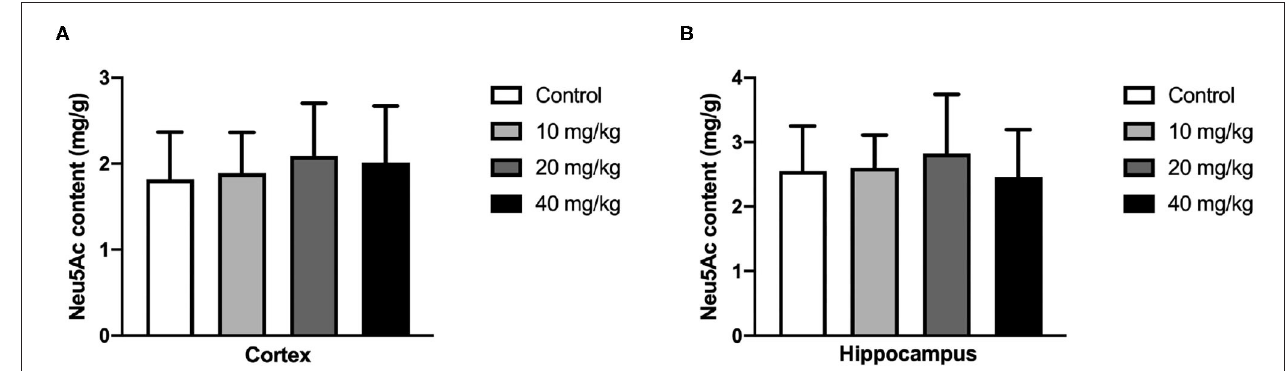
FIGURE 7 | Effects of perinatal Neu5Ac exposure on the brain Neu5Ac content in 100-day-old male rats. These rats were treated with Neu5Ac [10, 20, or 40 mg/(kg · day)] or water (as control) from the 21st day of age to the 45th day of age. The results are expressed as the M ± SD ; n = 10 per group.